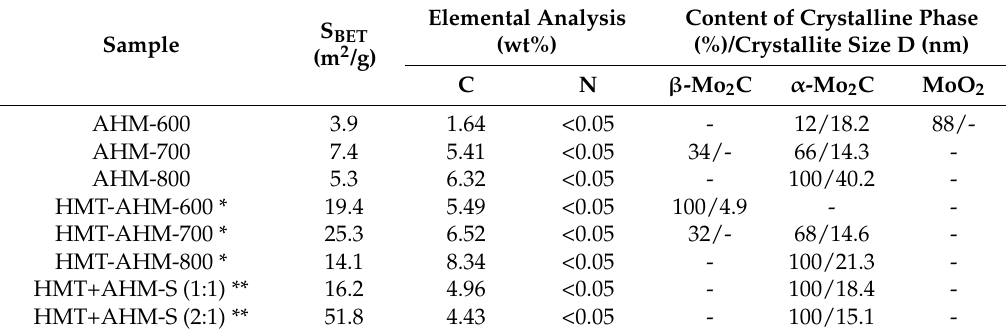
Table 1. Physicochemical properties of the prepared molybdenum carbides.